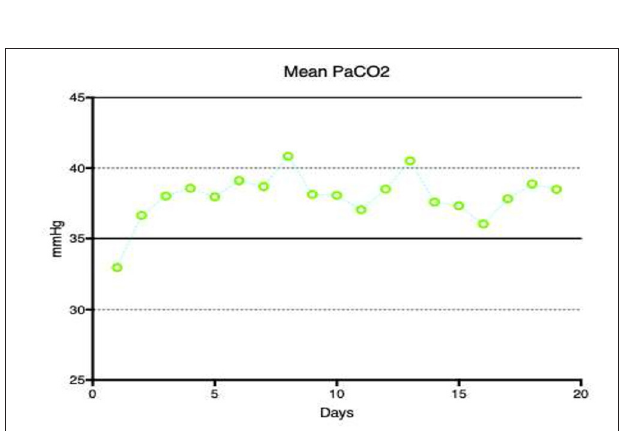
FIGURE 7 | Mean PaCo 2 for the duration of ECMO support.